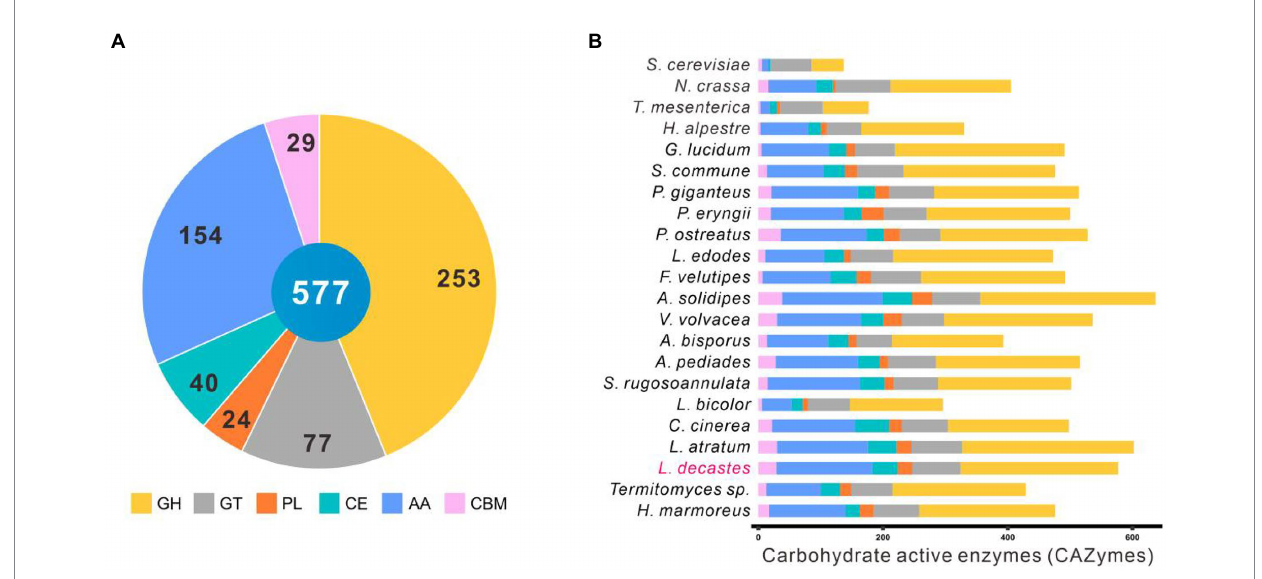
FIGURE 4 CAZymes in Lyophyllum decastes and other 21 fungi. (A) The distribution of CAZymes families in L. decastes . (B) The distribution of CAZymes in all 22 fungi (the same as those in Figure